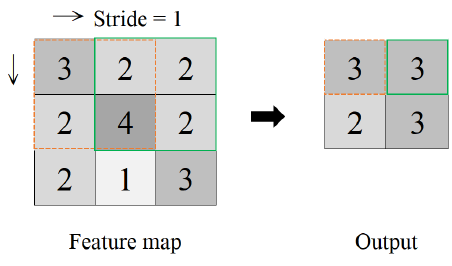
Figure 2. Example of average pooling with a 2 × 2 filter and stride of 1.